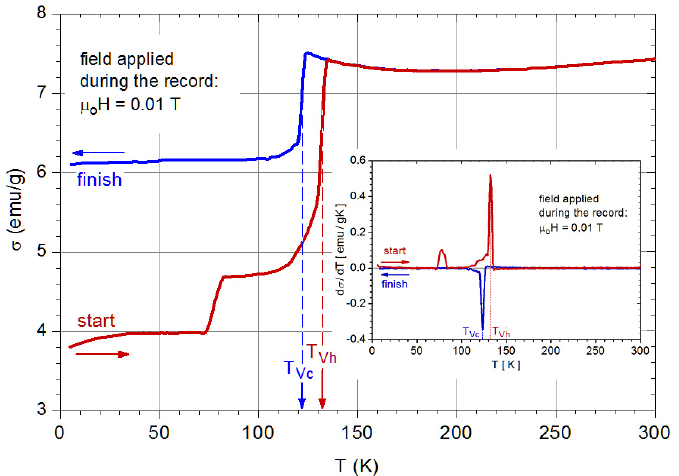
Figure 7. ZFC-FC magnetization vs. temperature records of the magnetite microcrystals. In the inset, the magnetization rate of change d σ /dT is plotted.